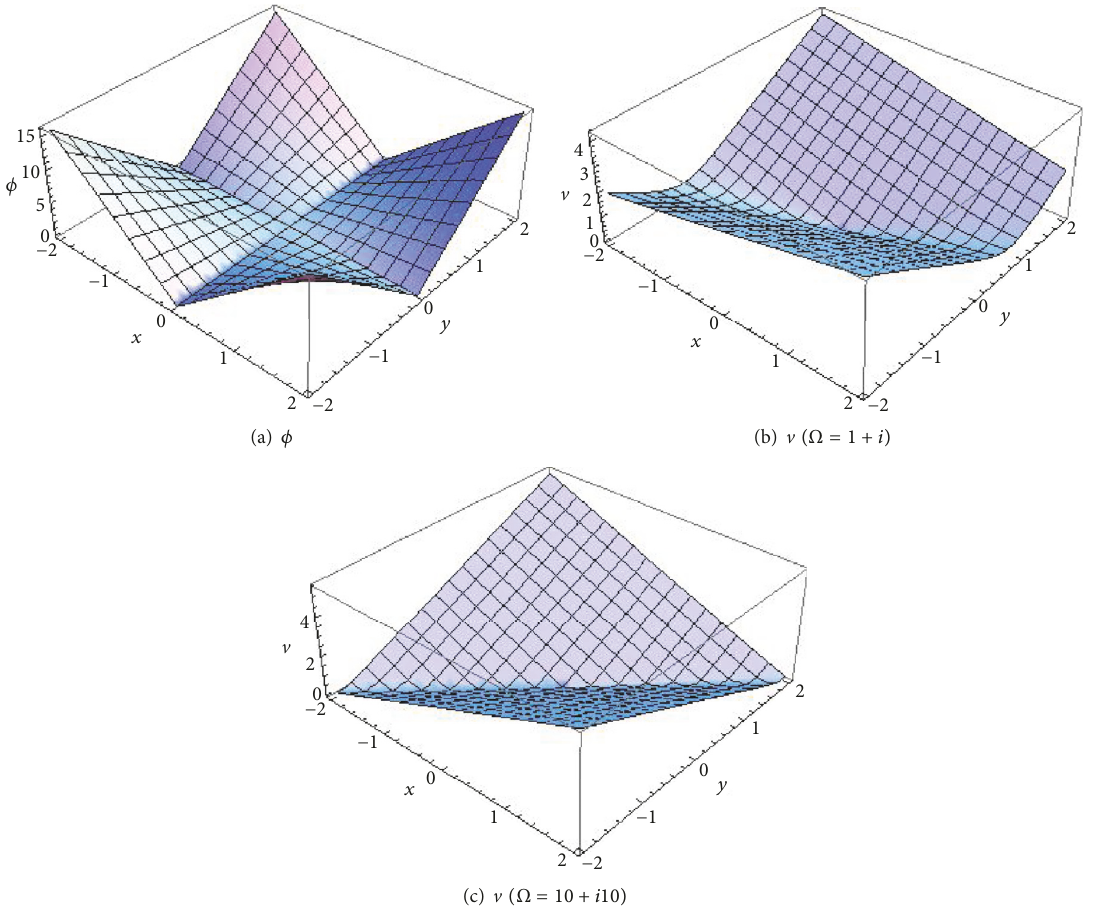
Figure 2: Plots of profiles of absolute value of 𝜙 (a) and velocities V when Ω = 1 + 𝑖 (b) and Ω = 10 + 𝑖10